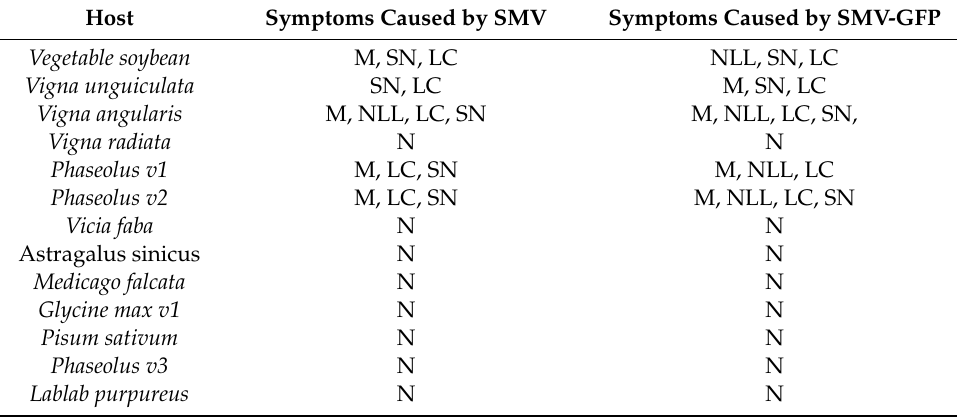
Figure 5. Infectivity of SMV from infectious clones in legume species. ( A ) Representative leaves with virus symptoms such as leaf curling, mosaic and local necrotic lesions were photographed. ( B ) RT-PCR analysis of SMV via coat protein (CP) region-specific primers is shown. CK, mock treatment; Line 1, SMV; Line 2, SMV-GFP; Line 3, positive control with the plasmid as template. ( C ) Detection of SMV titers in different plant species via RT-qPCR using CP- specific primers. Gm, Glycine max ; Nb, Nicotiana benthamiana ; Pv1, Phaseolus v1; Vu, Vigna unguiculata ; Pv2, Phaseolus v2; Va, Vigna angularis ; Vs, Vegetable soybean. Table 1. Symptoms in legume species upon infection with SMV infectious